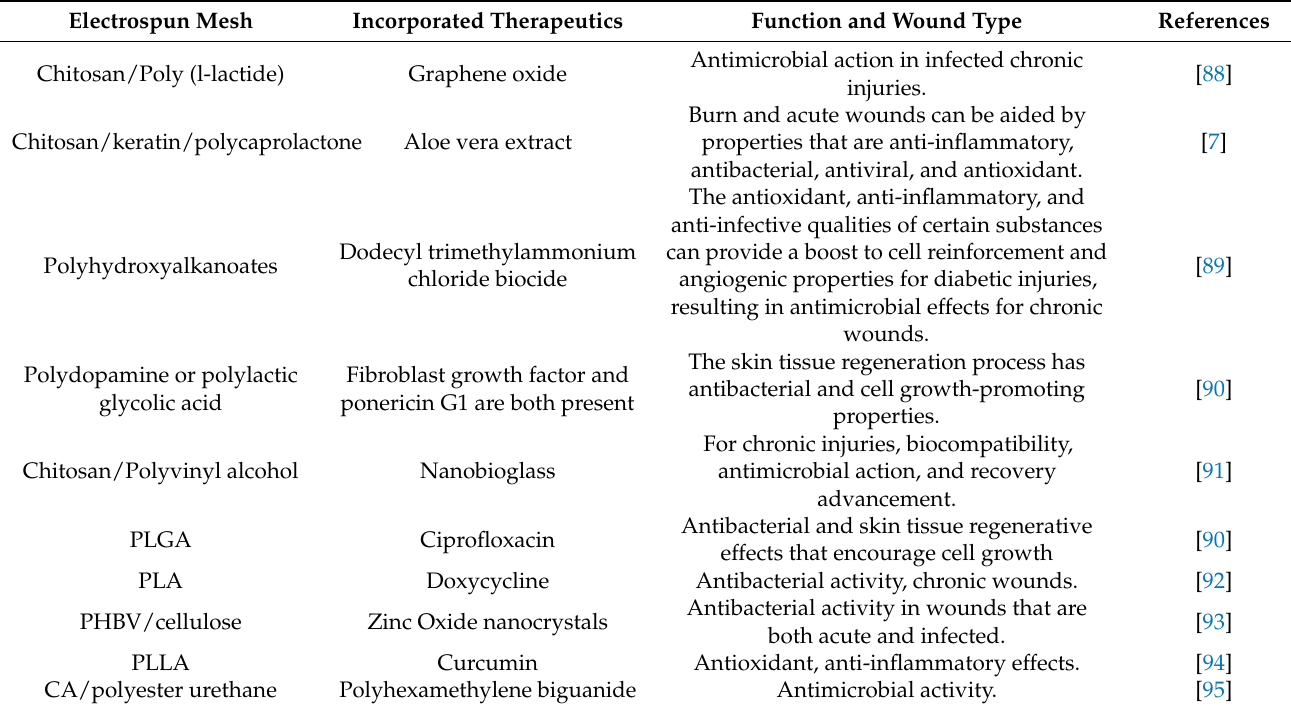
Table 4. Different electrospun biopolymer dressings with different functions and wound type